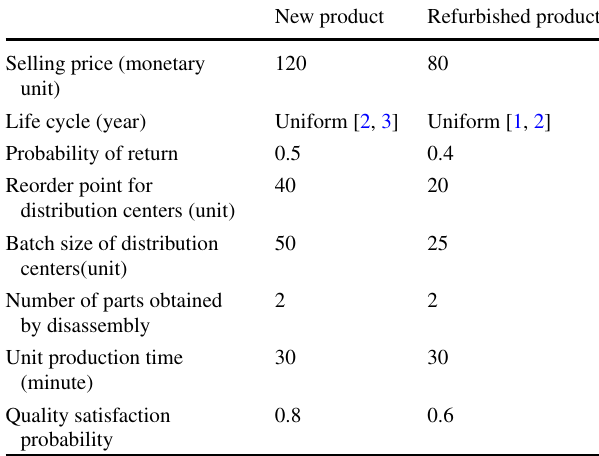
Table 1 Parameters of the model